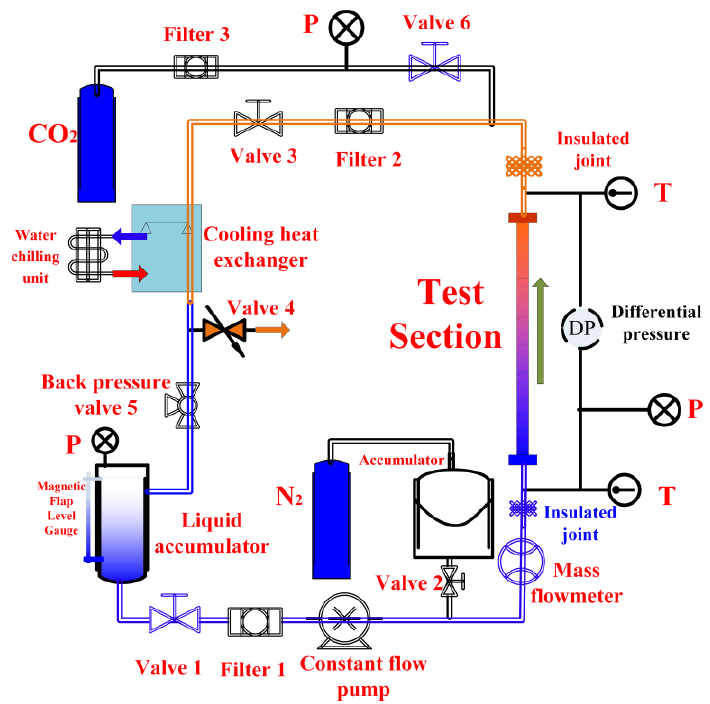
Figure 1. Schematic diagram of the experimental loop.